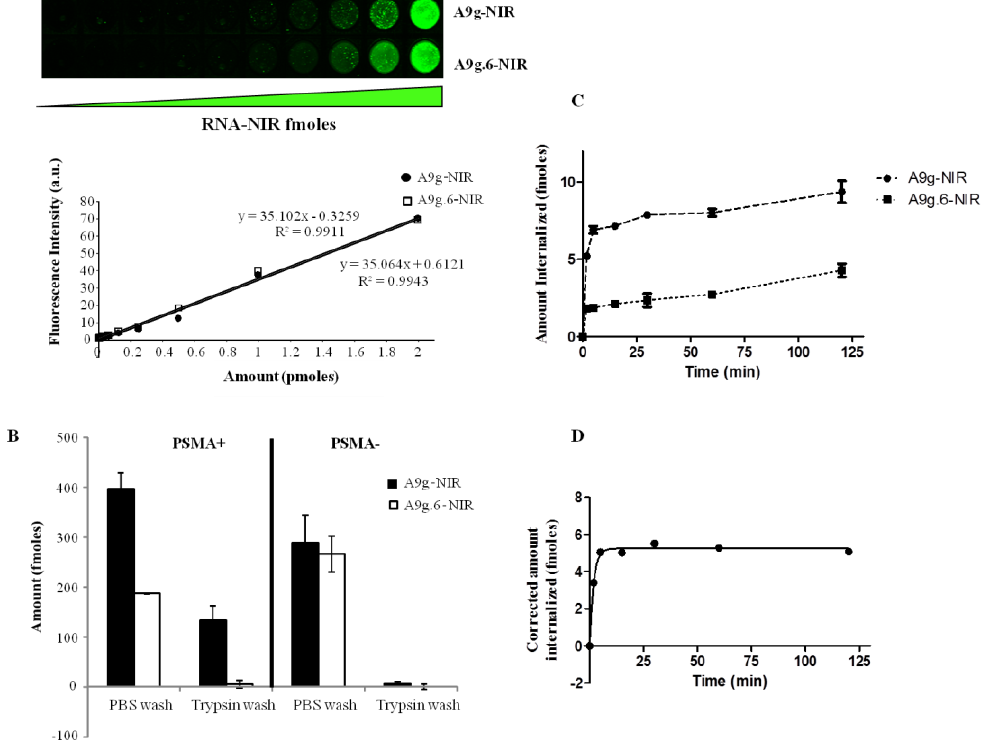
Figure 5. Quantitative and ultrasensitive internalization method ( “QUSIM” ). ( A ) 96-well microplate NIR Odyssey imager scan of serial dilutions for binding aptamer-NIR conjugate (A9g-NIR) and mutant, non-binding sequence conjugate (A9g.6-NIR) ( upper panel ) and standard curves with linear regression for RNA aptamer quantification ( lower panel ). ( B ) Quantification of the amount of aptamer-NIR internalized into PC3(PSMA+) cells vs. PC3(PSMA–) cells. ( C ) Time-dependent cell uptake of binding aptamer (A9g-NIR) vs. non-binding (mutant) aptamer (A9g.6-NIR). ( D ) Kinetics of specific A9g